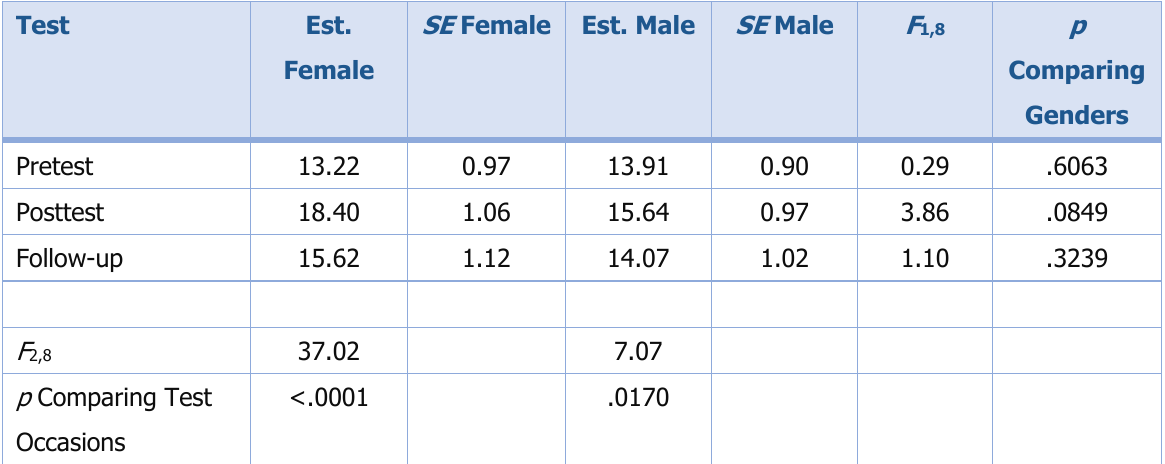
Table 2.Estimates by Gender and Test Occasions on the Overall Test for Objective 4